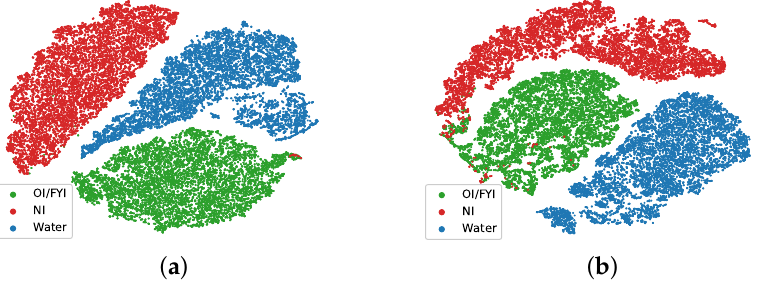
Figure 11. 2-D feature visualizations of the sea ice classes from the two testing sets, using the t-SNE algorithm for the second last layer of the NFNet. ( a ) The t-SNE diagram of the first testing set. ( b ) The t-SNE diagram of the second testing